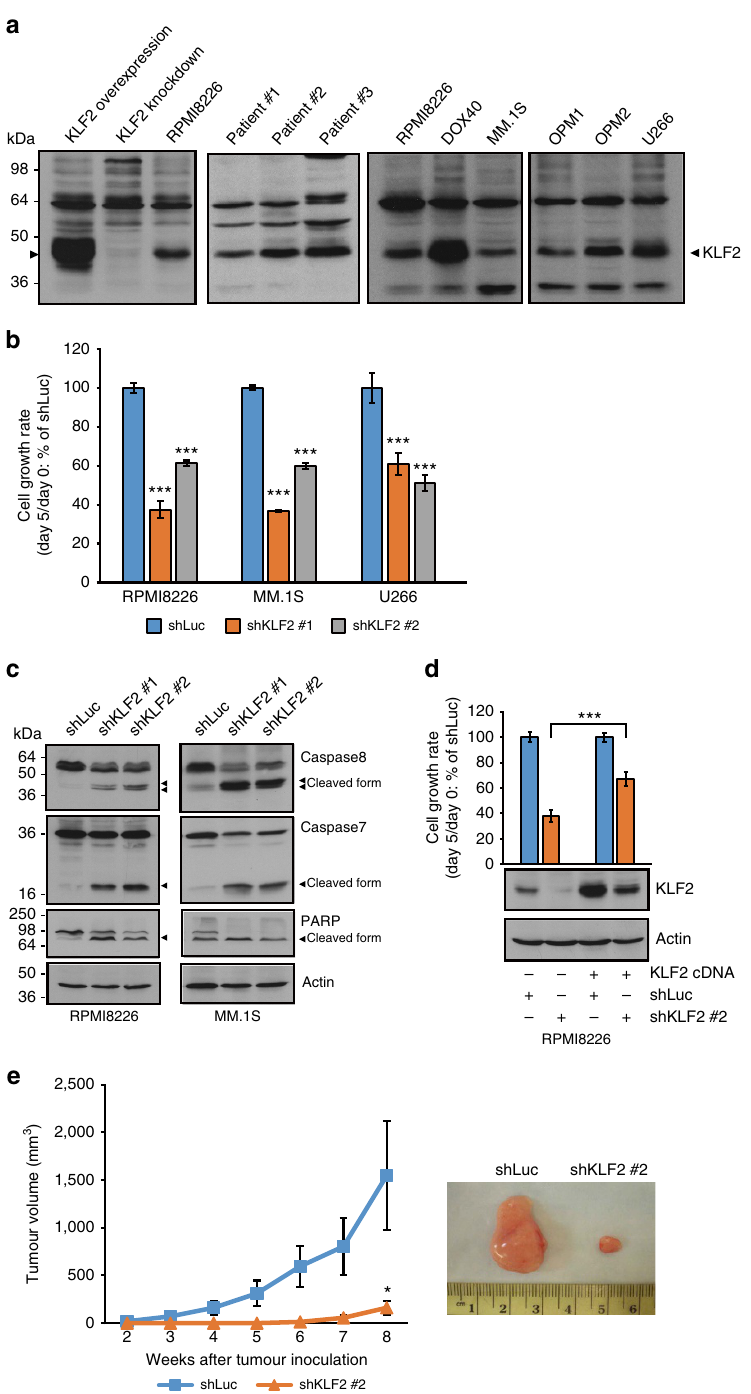
Figure 4 | KLF2 is required for MM cell survival. ( a ) Immunoblot analysis of KLF2 in patient MM cells and MM cell lines. Arrowhead represents KLF2. Whole-cell lysates from KLF2 -overexpressed or knockdown RPMI8226 cells were used as positive or negative control for KLF2 antibody (N2212), respectively. ( b ) MM cell lines (RPMI8226, MM.1S and U266) were transduced with either KLF2 -specific shRNA (shKLF2 #1 and #2) or control shLuc by lentivirus. Cell viability was measured on days 0 and 5 by MTT assay, and the cell growth rate (day 5/day 0) relative to shLuc was determined. ( c ) Immunoblot analysis of caspase 8, caspase 7 and PARP in KLF2 -knockdown RPMI8226 and MM.1S cells. Arrowheads indicate cleaved form. Actin served as the loading control. ( d ) RPMI8226 cells expressing the KLF2 cDNA carrying synonymous mutations in the shKLF2 #2 target sequence or empty vector were transduced with shKLF2 #2 or shLuc by lentivirus. The growth rate for control shLuc in each cell type expressing the KLF2 cDNA or empty vector is set as 100%. ( e ) MM.1S cells transduced with shKLF2 #2 or shLuc (4 (cid:2) 10 6 viable cells) were subcutaneously injected into SCID mice. Data represent mean ± s.e.m. n ¼ 7 mice per group. An image of a representative tumour in each group is shown (right panel). Data of control shLuc group are the same data shown in Fig. 2d since subcutaneous xenograft studies of MM.1S cells treated with shKDM3A and shKLF2 were performed simultaneously with a common control shLuc group. For b , d , data represent mean ± s.d. of quintuplicate cultures. For a – d , data are representative of at least two independent experiments, except for patient samples’ blot ( a ). * P o 0.05, *** P o 0.001 compared with control; Student’s t